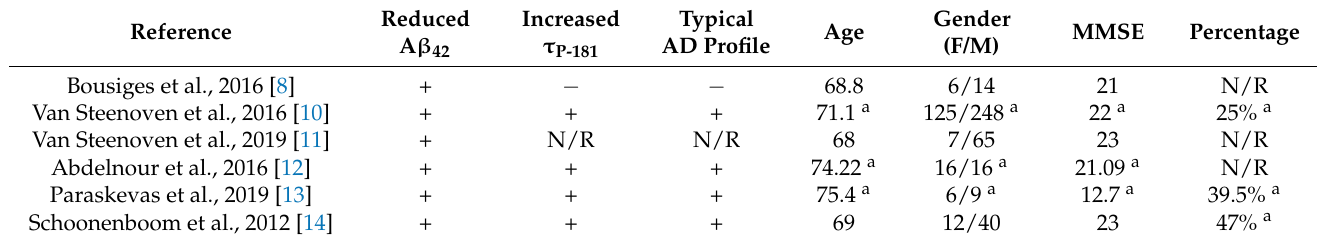
Table 1. Results of recent studies on classical CSF biomarkers in